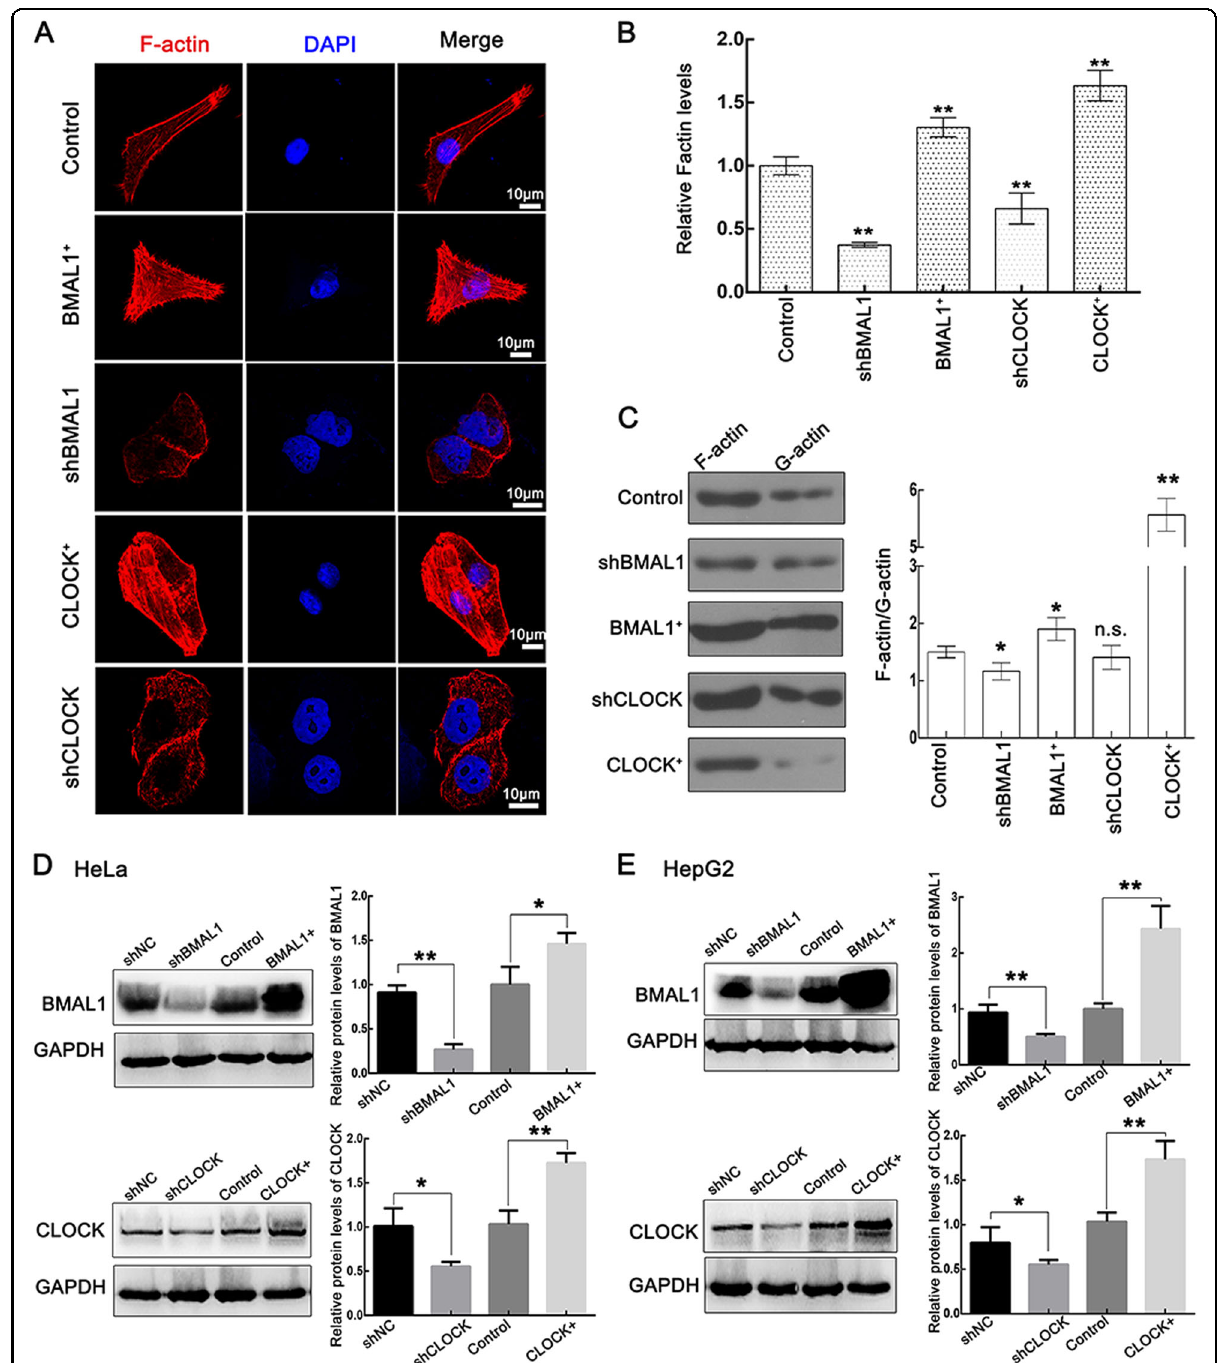
Fig. 1 CLOCK and BMAL1 enhance the formation of F-actin. a , b F-actin was stained with TRITC-phalloidin (Red) in HepG2 cells transfected with HA-tagged BMAL1 (BMAL1 + ), HA-tagged CLOCK (CLOCK + ), shRNA for BMAL1 (shBMAL1), and CLOCK (shCLOCK) vectors. Nuclei were stained with DAPI. The scale bars represent 10 μ m. The F-actin levels were quanti fi ed with the fl uorescence intensity ratio using ImageJ. The fl uorescence intensity of the control was taken as 1. Data were analyzed using a t test ( n = 3) and presented as the mean ± sd; * p < 0.05; ** p < 0.01. c F-actin and G-actin from control, shBMAL1, BMAL1 + , shCLOCK, and CLOCK + HeLa cells were separated by ultraspeed centrifugation and analyzed by western blotting using an antibody against β -actin. The mean ratio of F-actin to G-actin and SD were plotted, and a t test was performed ( n = 3); n.s. not signi fi cant; * p < 0.05; ** p < 0.01. d , e The expression levels of CLOCK and BMAL1 were veri fi ed by western blotting in HeLa and HepG2 cells transfected with the corresponding plasmids, respectively. GAPDH was used as a loading control, and the protein level of the control was taken as 1. Data were analyzed using a t test ( n = 3) and presented as the mean ± sd; * p < 0.05; ** p < 0.01